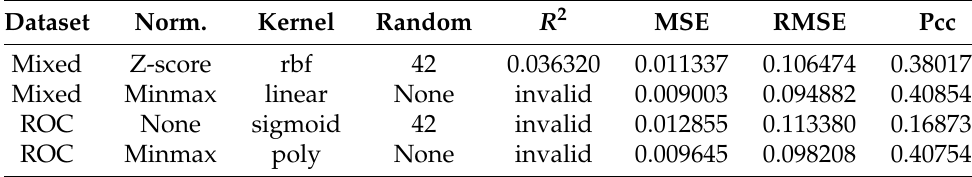
Table 3. Top 2 best metric performers in SVR.